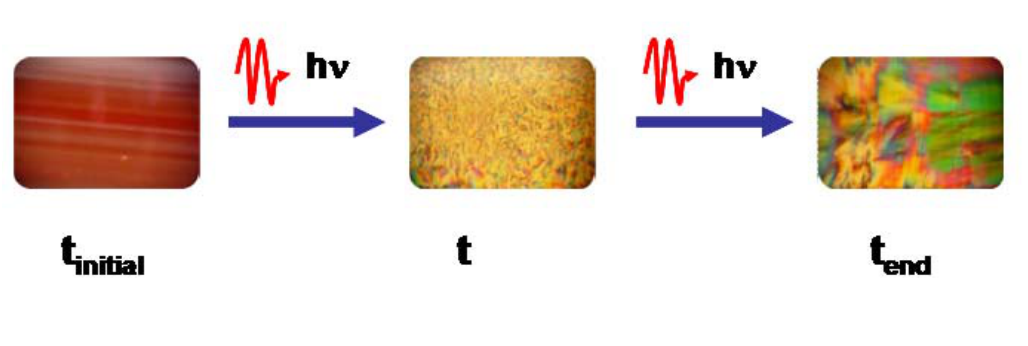
E water/deca- 10 4